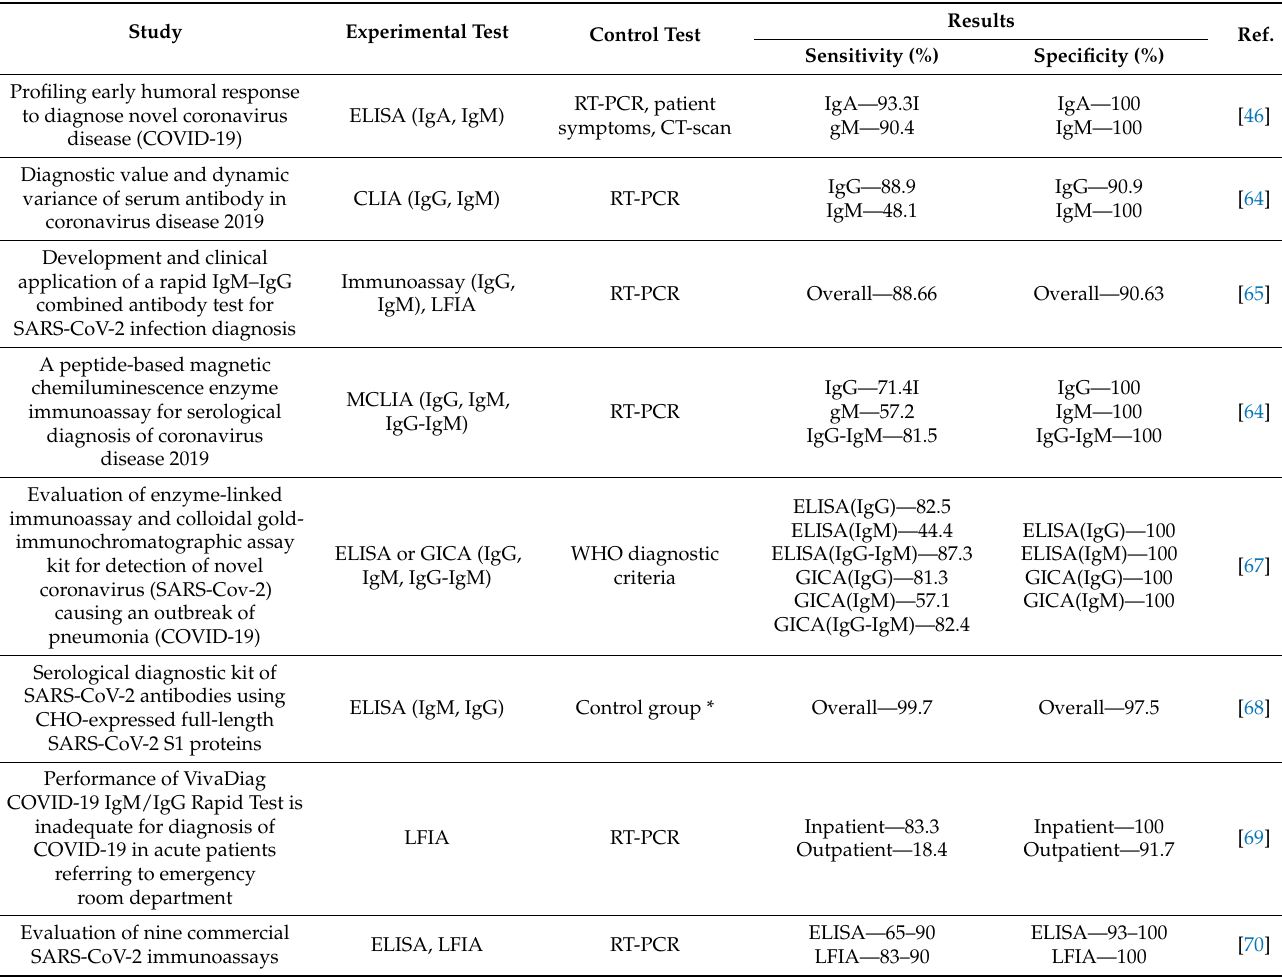
Table 4. Comparing sensitivity and specificity between different studies that looked at serological